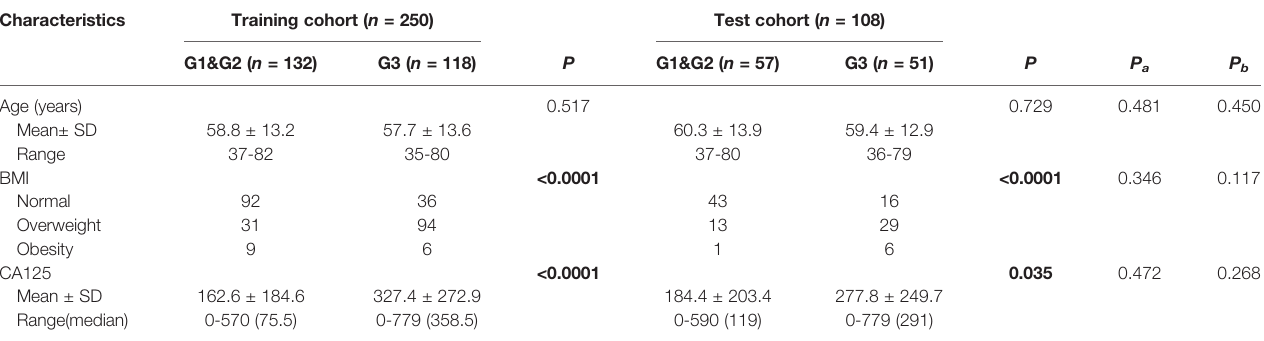
TABLE 2 | Patient characteristics in the training and test cohorts.